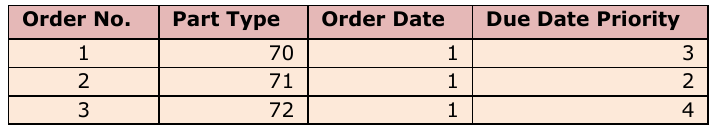
Table 3. Production Order for Production